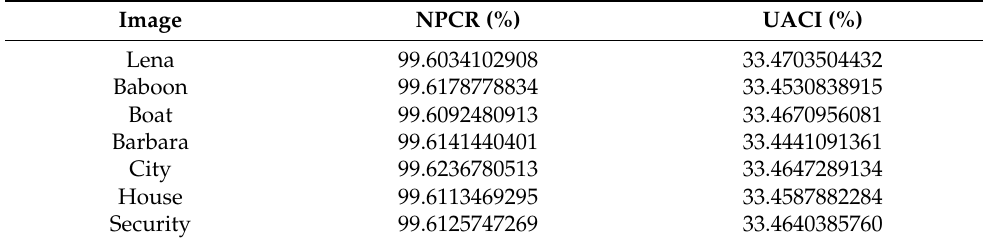
Table 8. NPCR and UACI results.